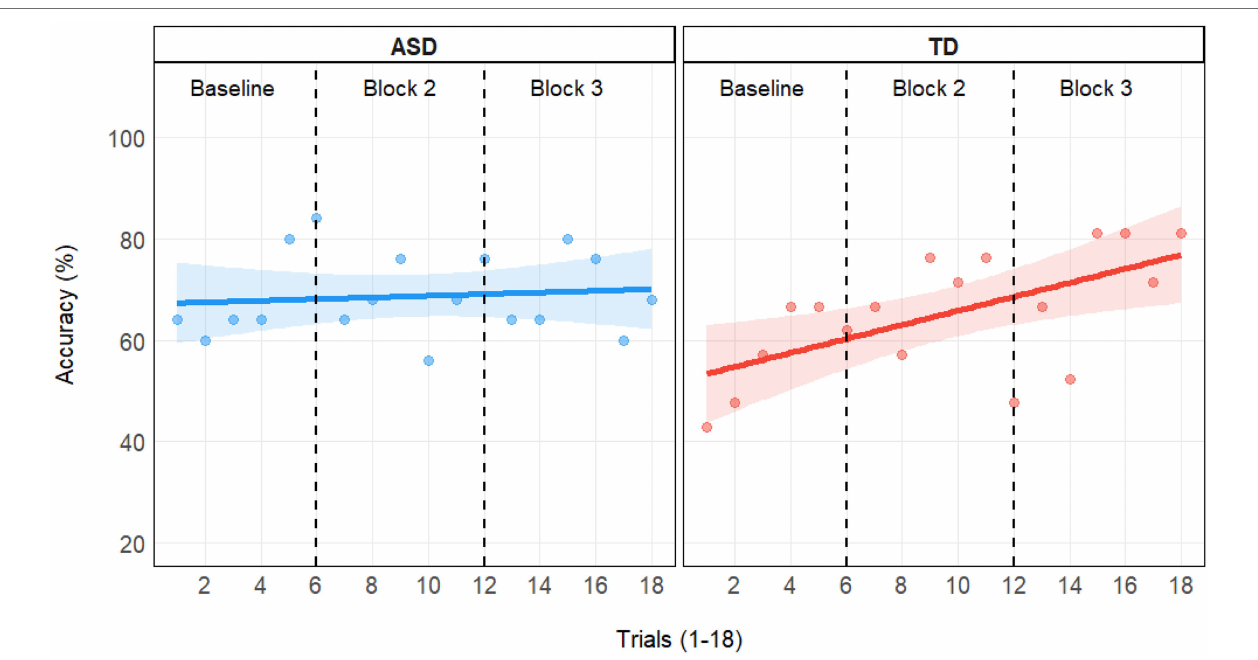
FIGURE 3 | Average accuracies per group (ASD left panel; TD right panel) for each trial (1–18) in the Embedded Figure Task (EFT). One point depicts the percentage of accurate responses in the Embedded Figures Task per trial number in groups (ASD left panel; TD right panel). Linear regression lines with confidence bands fitted per group. Black dashed lines illustrate the block limits: Trials 1–6 were baseline trials, which were followed by two blocks each with 6 trials that included global or local priming in a counterbalanced order.